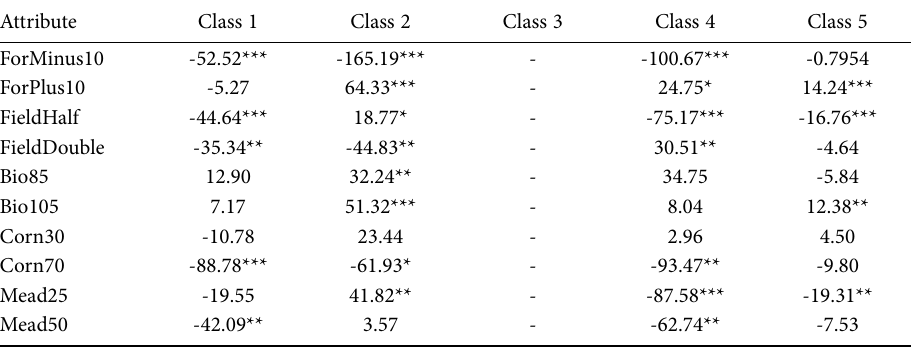
Table 6. Willingness to pay values.